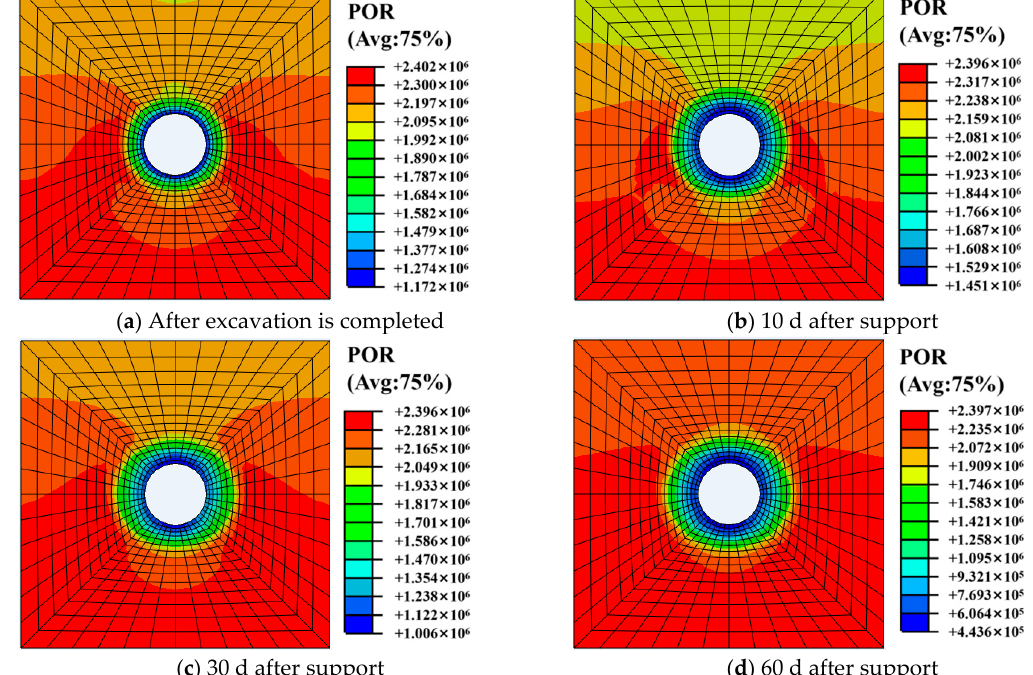
Figure 5. Pore pressure distribution of surrounding rock at different times.